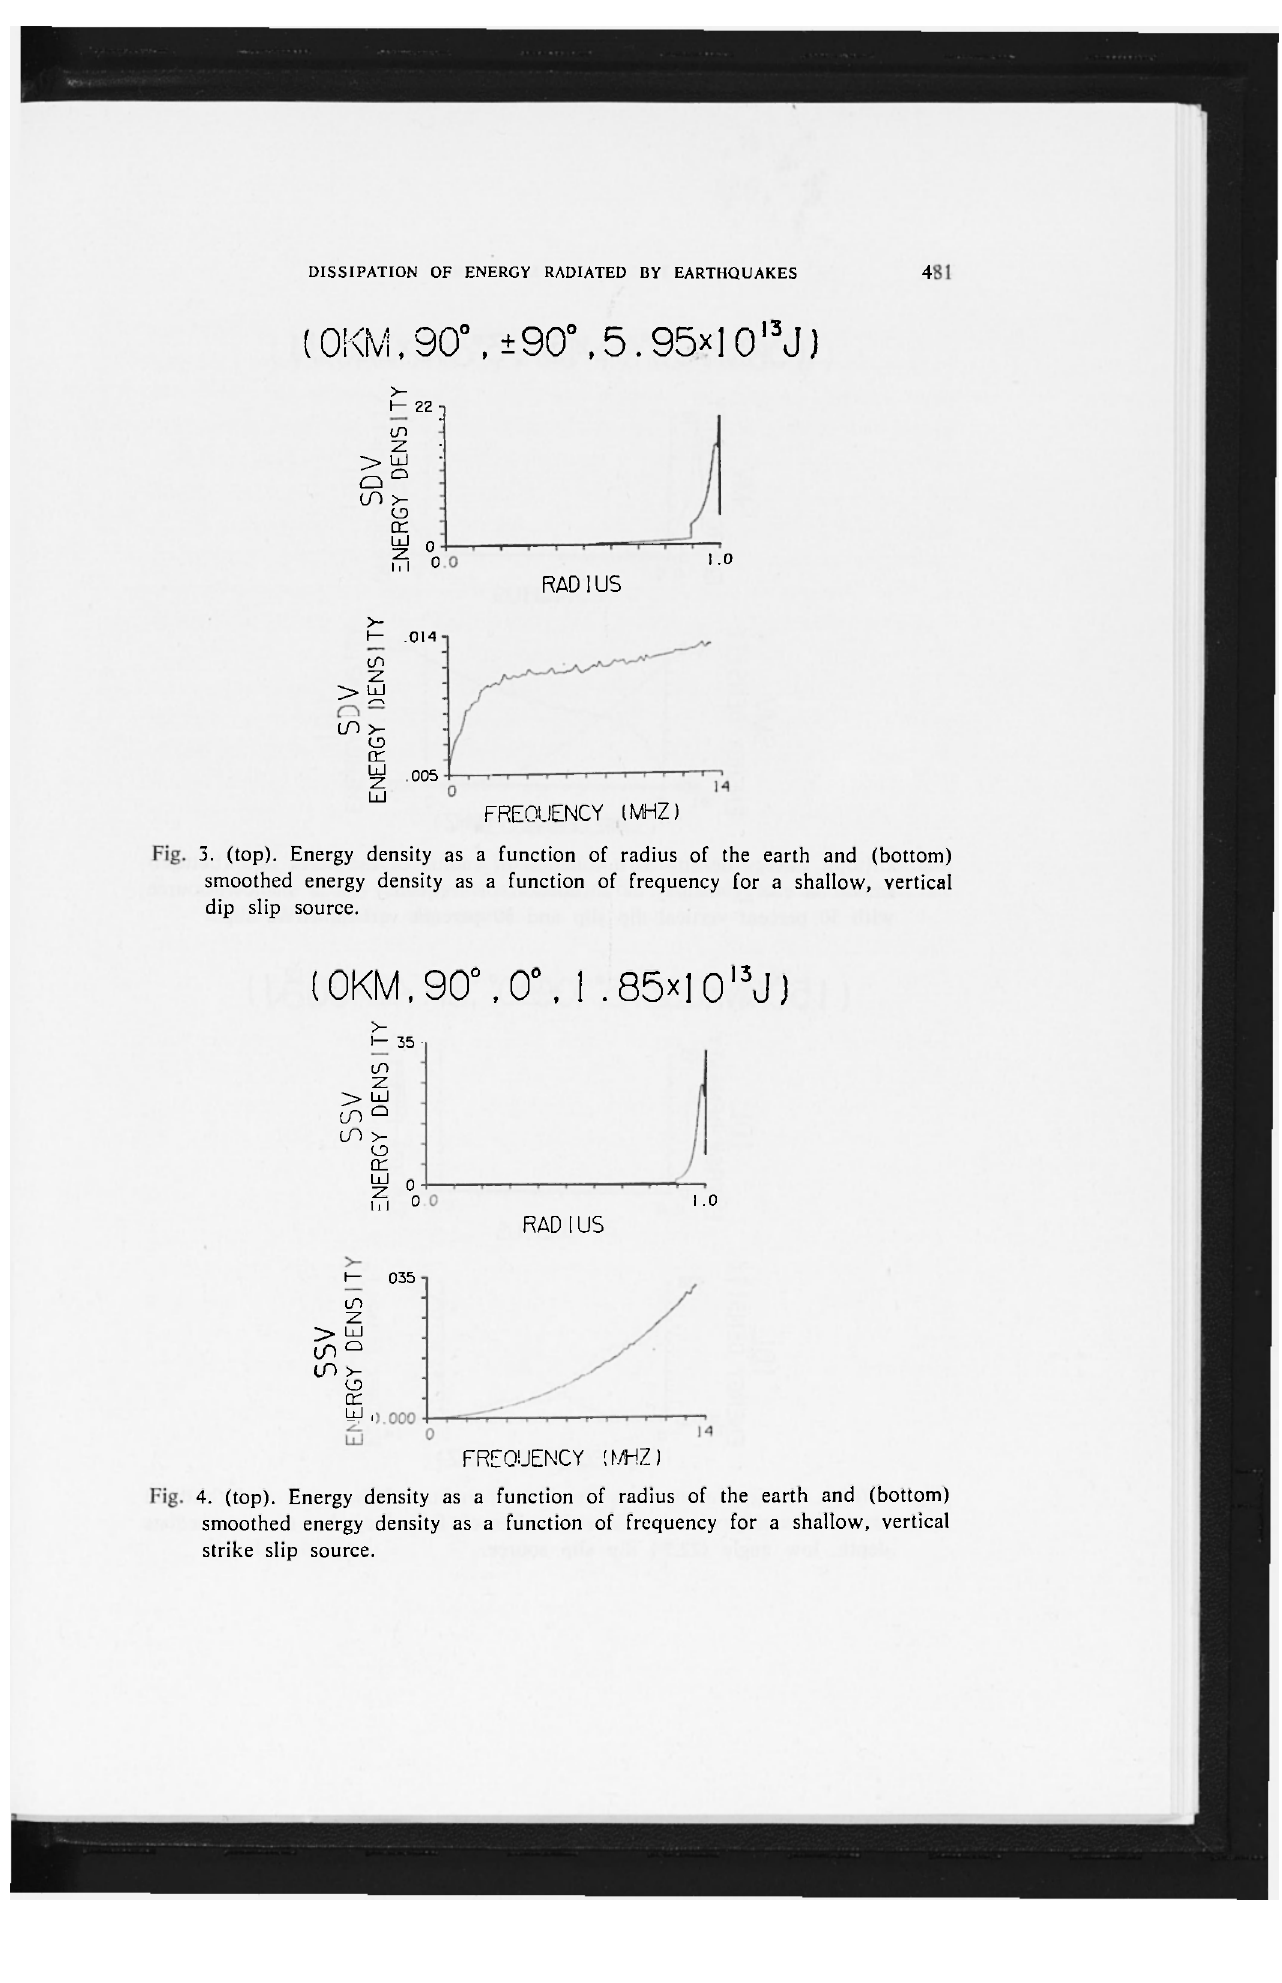
4. (top). Energy density as a function of radius of the earth and (bottom) smoothed energy density as a function of frequency for a shallow, vertical strike slip